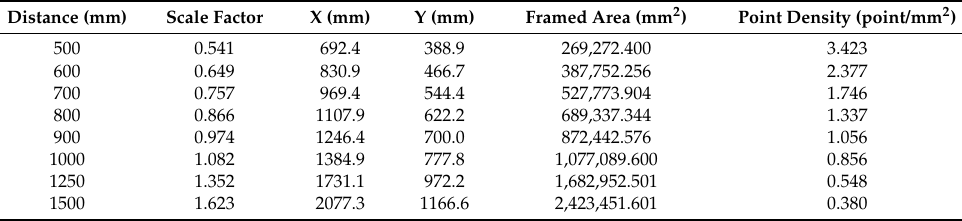
Table 2. The point density and framed area variation at increasing camera–scene distance, computed using the FOV indicated in the Intel specifications (69.4 × 42.5 ◦